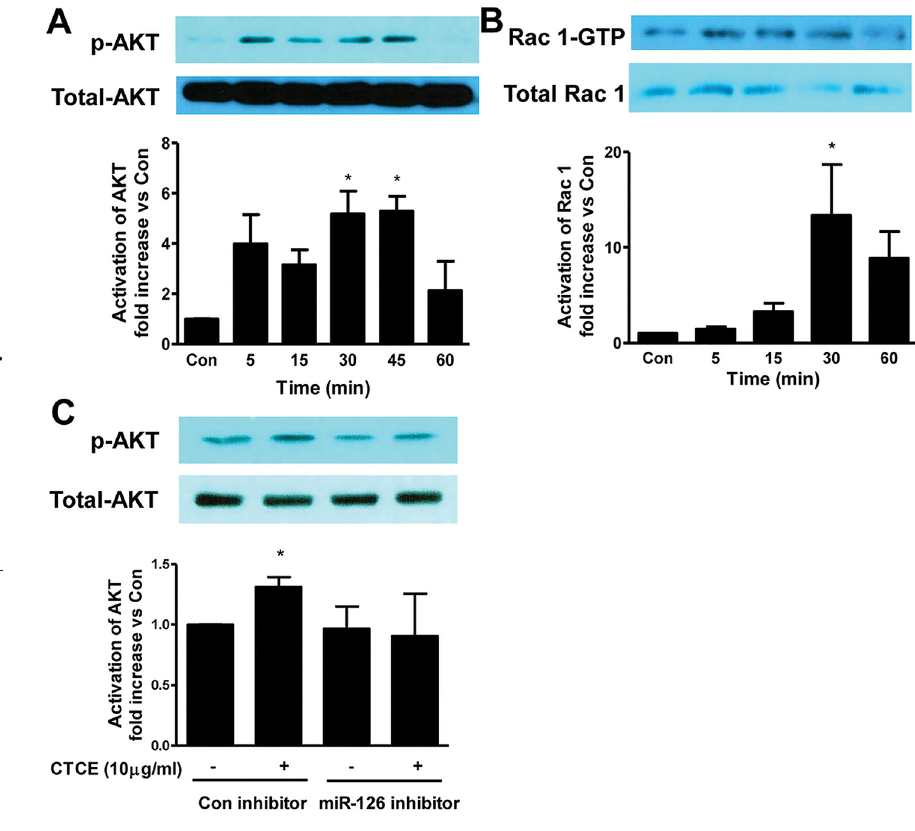
Figure 4. CTCE increased AKT/Rac 1 signaling in HMVECs. HMVECs were treated with CTCE (10 μg/mL) for different time intervals. AKT activation (A) and Rac 1 activation (B) were determined by Western blot and Rac 1 activation assay kit. HMVECs were also transfected with miR-126 inhibitors or control inhibitors and CTCE-induced AKT activation was deter- mined (C). * p < 0.05 compared with control group. N = 3–5 independent